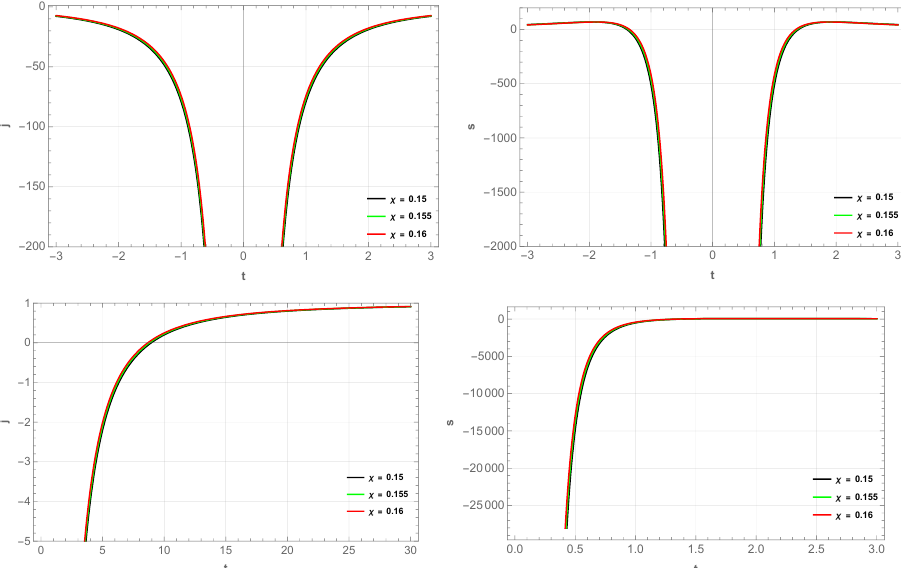
Figure 4. Symmetric behavior of the jerk parameter ( above left panel ) and snap parameter ( above right panel ) versus cosmic time t . The jerk ( below left panel ) and snap ( below right panel ) parame- ter in positive time